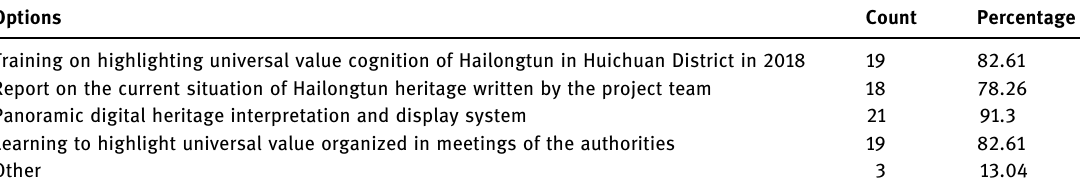
Table 4 : Question: Which methods do you think are most helpful for enhancing the outstanding universal value of Hailongtun?